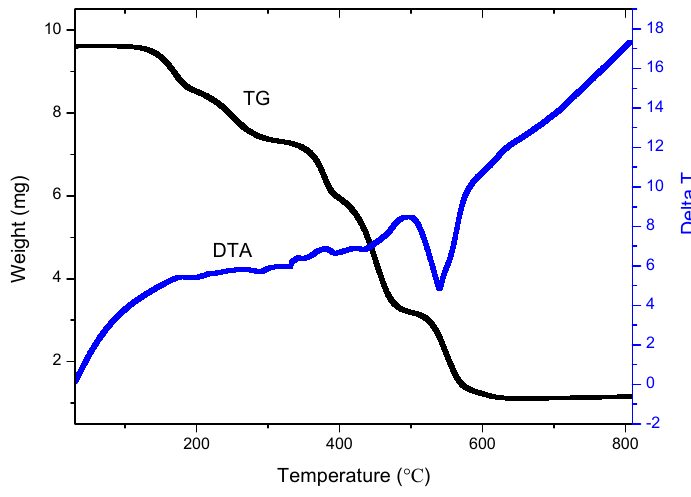
Figure 8. The TG-DTA curves of compound 1 .